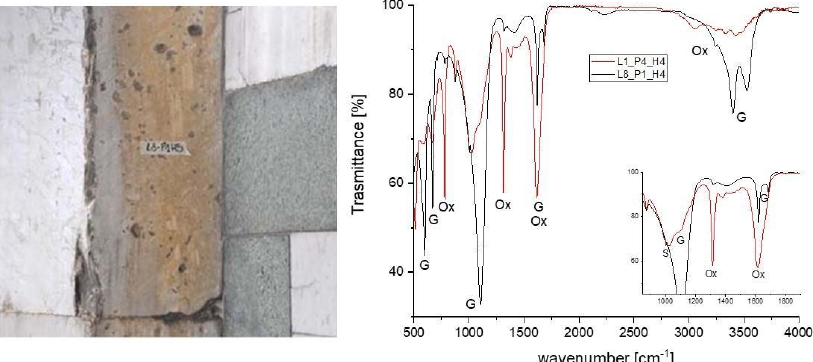
Figure 5. Photographic documentation of yellow-brown patinas on marble cladding. FT-IR spectra of two analyzed patinas, samples L1_P4_H4 and L8_P1_H5: G, gypsum; Ox, calcium oxalate; S, silicate.